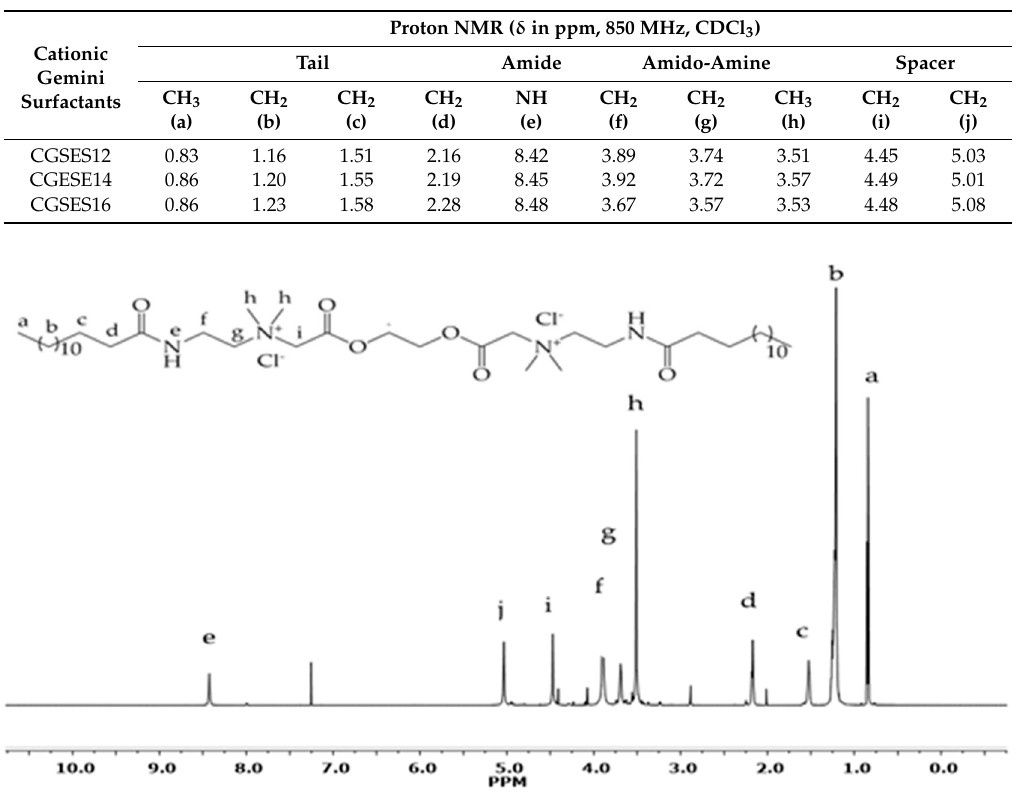
Figure 2. 1 H-NMR spectrum CGSES14.